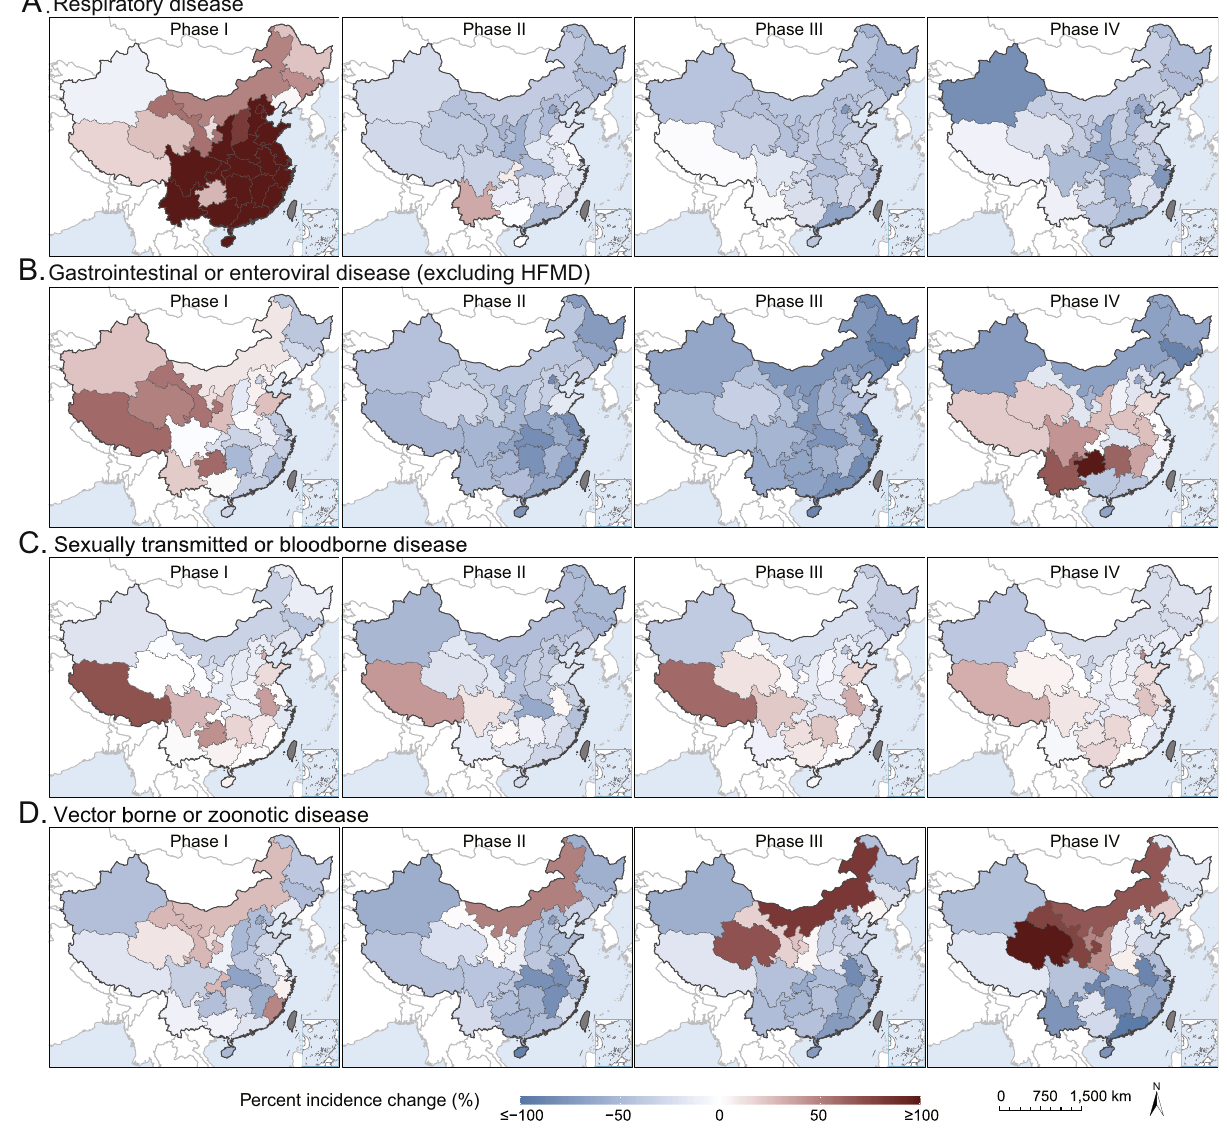
Fig. 1 Percent changes of cumulative incidence in each epidemic phase between 2020 and the average of 2014 − 2019 at the province level for four categories of noti fi able infectious diseases. A Respiratory disease, B gastrointestinal or enteroviral disease (excluding HFMD), C sexually transmitted or blood-borne disease, D vector-borne or zoonotic disease. The epidemic phases are de fi ned as before Jan 22 (Phase I), Jan 23 – Apr 7 (Phase II), Apr 8 – Aug 31 (Phase III) and after Sep 1 (Phase IV). Gradient red and blue colors indicate positive and negative changes from 2014 to 2019, shaded gray indicates the missing